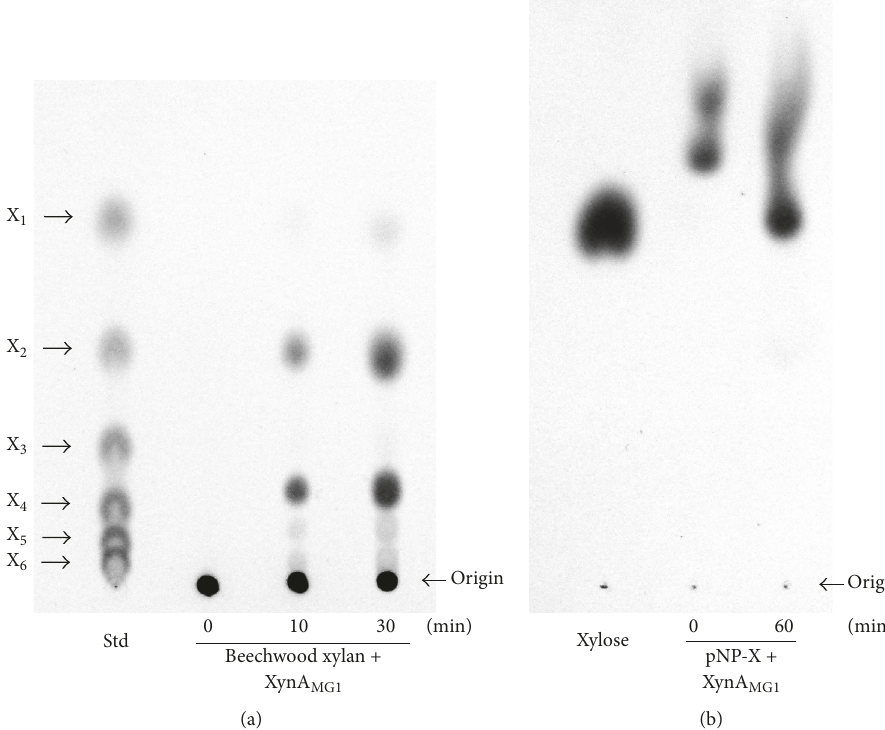
Figure 5: Thin-layer chromatography analysis of end products of XynA MG 1 catalyzed hydrolysis of beechwood xylan (a) and 4-nitrophenyl- 𝛽 -D-xylopyranoside (b). X 1 , xylose; X 2 , xylobiose; X 3 , xylotriose; X 4 , xylotetraose; X 5 , xylopentaose; X 6 , xylohexaose; Std, molecular weight standard mix of X 1 to X 6 ; pNP-X, 4-nitrophenyl- 𝛽 -D-xylopyranoside.